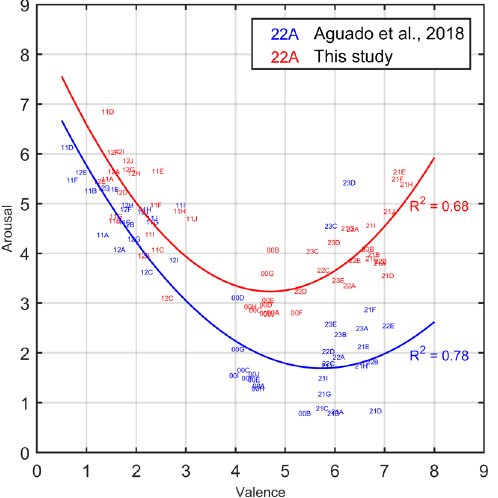
Figure 5. Mean valence and arousal ratings for affective film clips. Labels correspond to the original identifiers of the stimuli (Aguado et al. , 2018 ). Blue labels represent data obtained with the SAM (Aguado et al. , 2018) while red labels represent data obtained with the EmojiGrid (this study). The curves show quadratic fits to the corresponding data points.